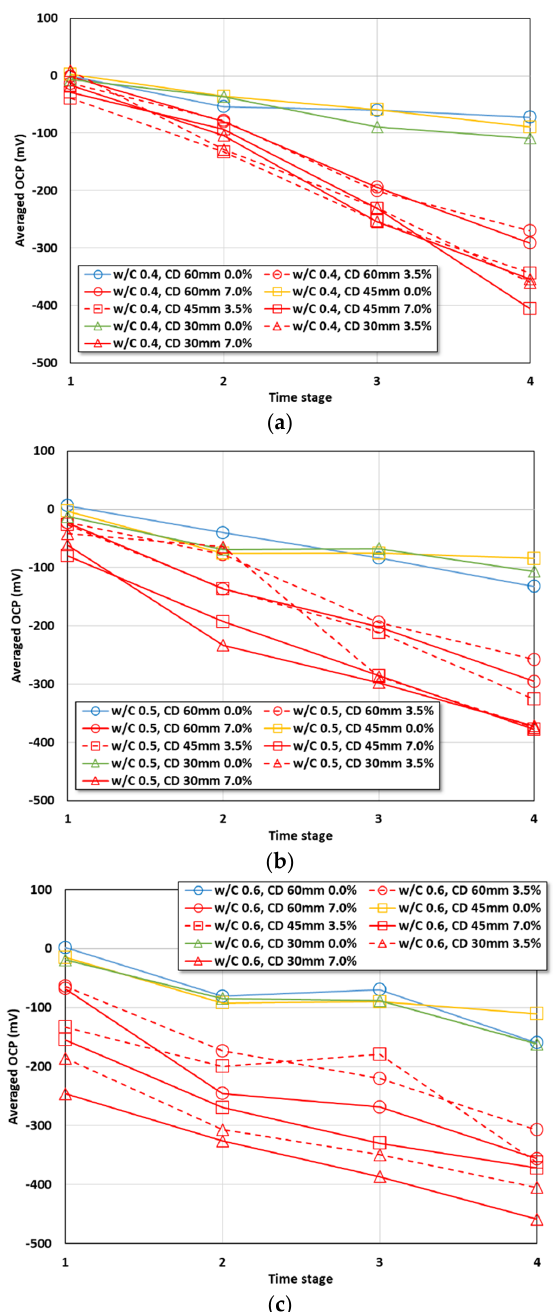
Figure 12. Open-circuit potential (OCP) drop with increasing exposure period. Water-to-cement ( w/c ) ratios: ( a ) 0.4, ( b ) 0.5, and ( c ) 0.6. When each exposure environment is fixed, a relatively high coefficient of determi- nation can be derived by obtaining multiple correlations of time, cover depth, and OCP.